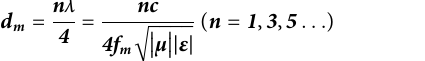
absorption material, while | ε | and | μ | are the modulus values of the permittivity and permeability at the corresponding frequency, respectively. Figure 2C shows the RL curve of the single-layer CB-ABS absorption composites with different thicknesses. The change curve of d m and f m corresponding to CB-ABS calculated by the λ /4 matching model is shown in Figure 2D. The solid dots of different colors in Figure 2D are the matching thickness d m and its corresponding absorption peak frequency f m , which extracted from the RL curve with different thicknesses in Figure 2C. And they are basically located around the λ / 4 curve, indicating that the absorption peak of the single-layer CB-ABS absorption composite material obeys the λ / 4